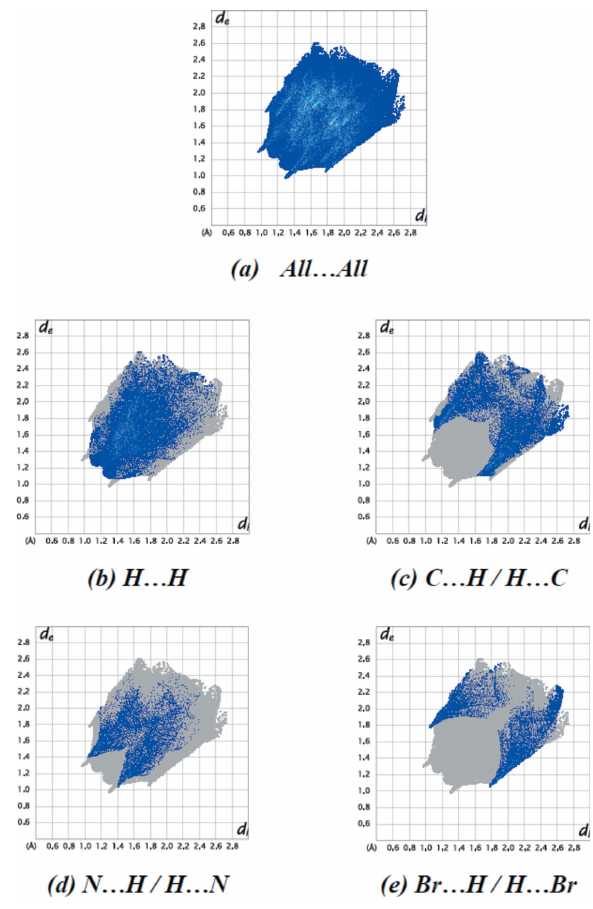
Figure 7 The two-dimensional fingerprint plots of the title compound, showing ( a ) all interactions, and delineated into ( b ) H (cid:2)(cid:2)(cid:2) H, ( c ) C (cid:2)(cid:2)(cid:2) H/H (cid:2)(cid:2)(cid:2) C, ( d ) N (cid:2)(cid:2)(cid:2) H/H (cid:2)(cid:2)(cid:2) N and ( e ) Br (cid:2)(cid:2)(cid:2) H/H (cid:2)(cid:2)(cid:2) Br interactions. [ d e and d i represent the distances from a point on the Hirshfeld surface to the nearest atoms outside (external) and inside (internal) the surface,